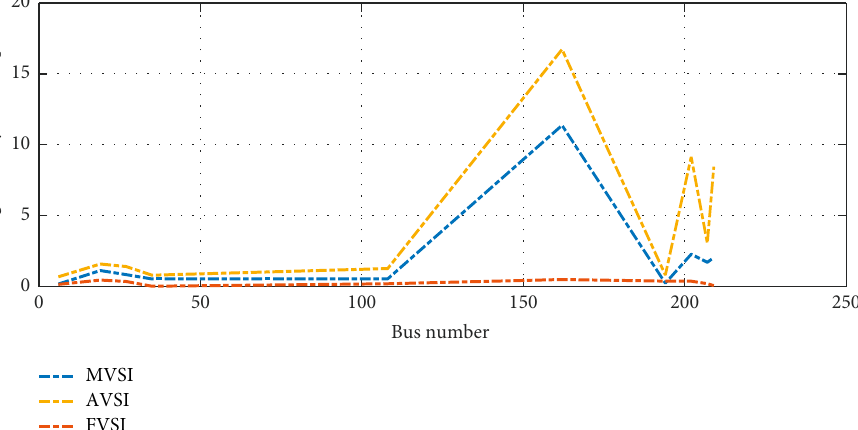
Figure 8: Voltage stability indices at 30% load increase.